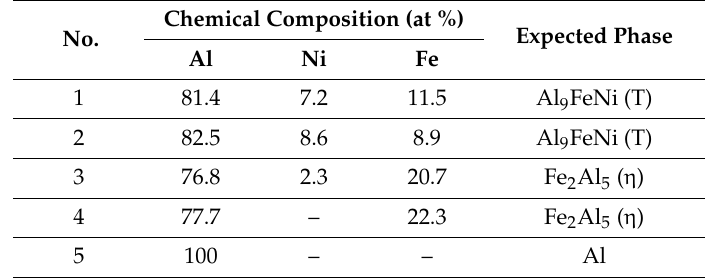
Table 3. EDS microanalysis results of the phases denoted as 1–5 in Figure 5d.